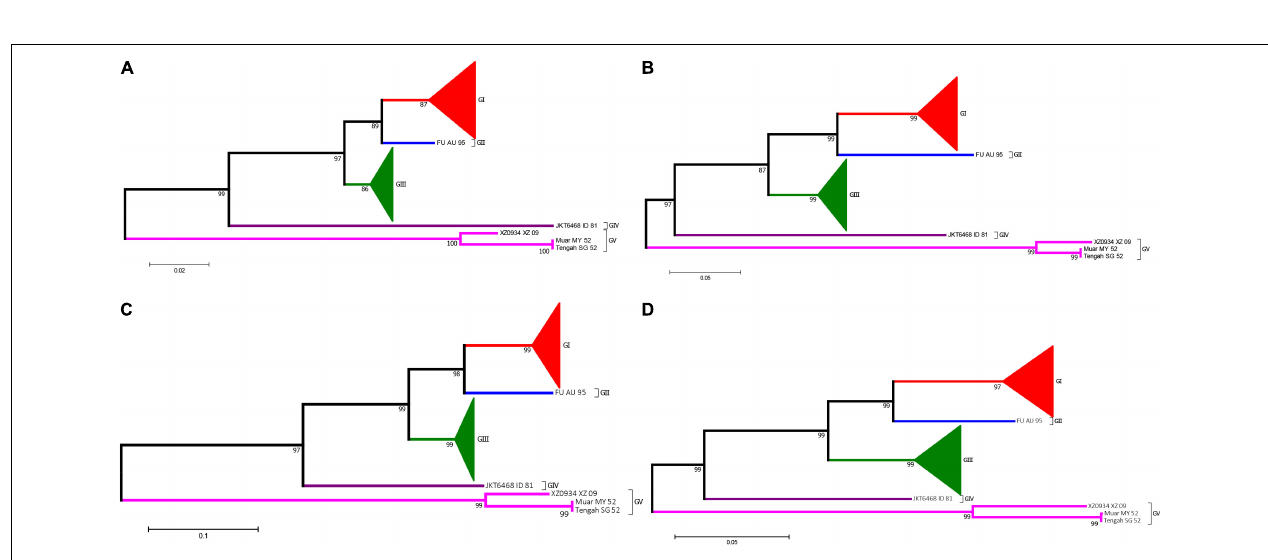
FIGURE 7 | Phylogenetic analysis of JEV. (A) The phylogenetic tree based on the sequences (1–300 nt) of domain I (VR) within the 3 (cid:48) UTRs of JEV. (B) The phylogenetic tree based on the PrM gene of JEVs. (C) The phylogenetic tree based on the E gene of JEVs. (D) The phylogenetic tree based on the ORF gene of JEVs. Red, blue, green, purple and violet were used to mark genotype I, II, III, IV, and V of JEV, respectively. The triangles were used to condense strains of the same genotypes.